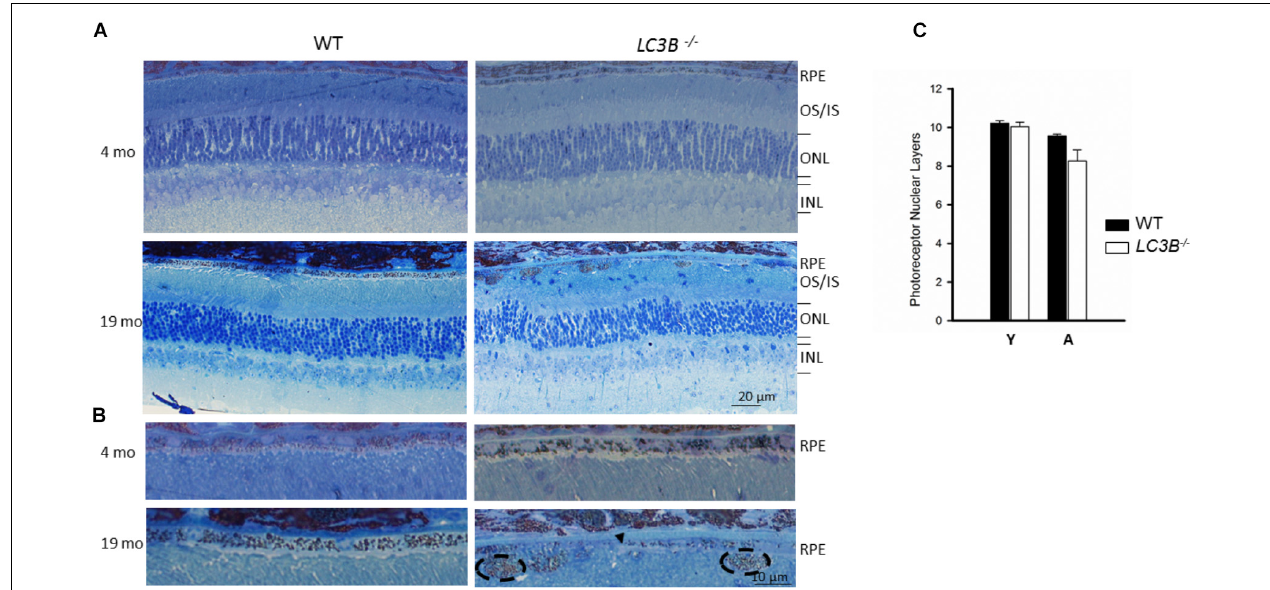
FIGURE 3 | Representative images for semithin sections from 4 and 19 months old WT and L3CB − / − stained with 1% Toluidine blue showing retinal layers (A) and RPE (B) . Older L3CB − / − shows abnormal features in the RPE/sub-RPE space including hypopigmentation (arrow-head) and hyperpigmentation (dotted oval). (C) Bar graph showing average number of nuclear layers in the ONL (outer nuclear layer) for young (Y, 3–4 months) and aged (A, 16–19 months) mice. OS/IS, outer segment/inner segment; INL, inner nuclear layer.